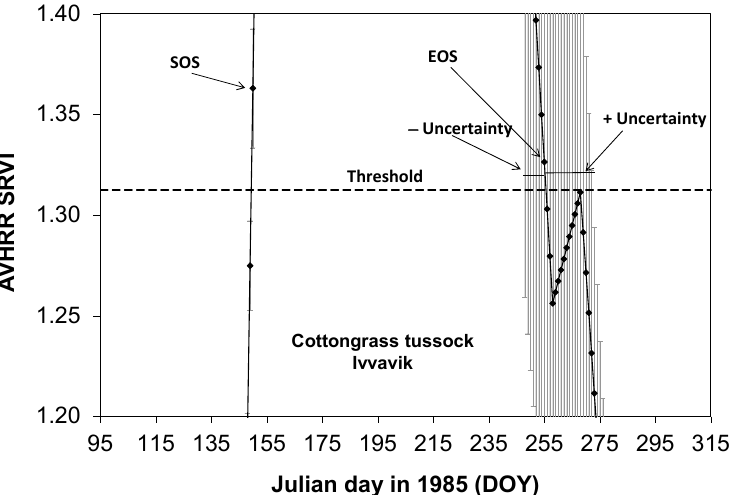
Figure 2. A methodological diagram showing the determination of SOS, EOS, and GSL and their uncertainties for the cotton-grass tussock class in the Ivvavik National Park.